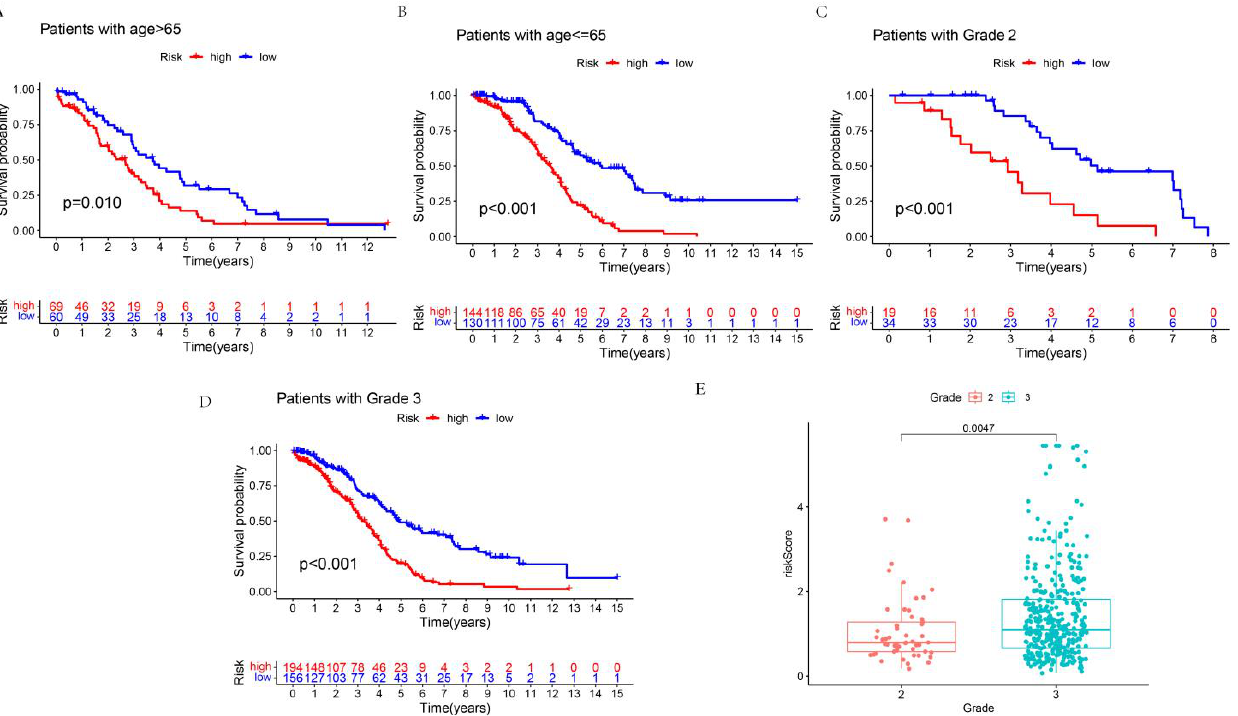
Figure 3. Assessment of prognosis-related protein model for disease-free interval (DFI), disease- specific survival (DSS), and progression-free interval (PFI). ( A ) Kaplan–Meier survival curve for DFI between high- and low-score groups in the training, testing ( B ), and whole ( C ) sets. ( D ) ROC curve for 1-year, 3-year, and 5-year DFI in the training, testing ( E ), and whole ( F ) sets. ( G ) Kaplan–Meier survival curve for DSS between high- and low-score groups in the training, testing ( H ), and whole ( I ) sets. ( J ) ROC curve for 1-year, 3-year, and 5-year DSS in the training, testing ( K ), and whole ( L ) sets. ( M ) Kaplan–Meier survival curve for PFI between high- and low-score groups in the training, testing ( N ), and whole ( O ) sets. ( P ) ROC curve for 1-year, 3-year, and 5-year PFI in the training, testing ( Q ), and whole ( R ) sets.